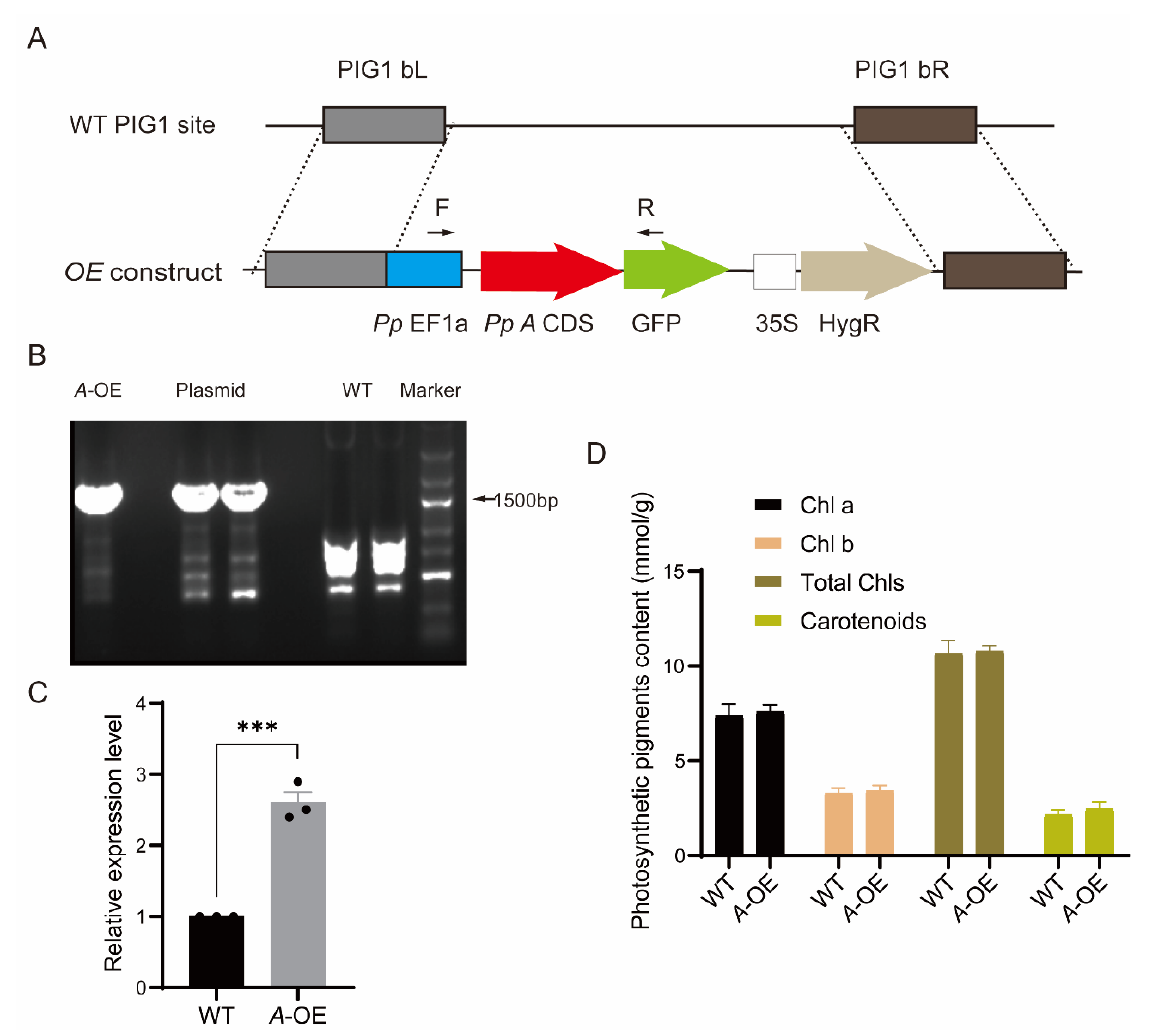
Figure 3. Stable PpRNH1A -overexpression lines in P. patens . ( A ) Schematic diagram of pPOG1- A construct. P, plasmid; PIG1 bL, left targeting site; PIG1 bR, right targeting site; Pp EF1a, the EF1a promoter from P. patens ; HygR, hygromycin selectable marker cassette; GFP, green fluorescent protein. ( B ) Positive PpRNH1A -overexpression ( A -OE) plants were confirmed at DNA level. WT, wild type; A -OE, PpRNH1A -overexpressing plant. ( C ) Identification of A -OE plant by qRT-PCR at RNA level. ( D ) Pigment contents in WT and A -OE under normal growth conditions. Chl a: chlorophyll a; Chl b: chlorophyll b; Total Chls: Total chlorophylls. For ( C , D ), data are presented as means ± SEM of three replicates; t -test was used for statistics; asterisks indicate the significant difference between WT and A -OE, *** p < 0.001.